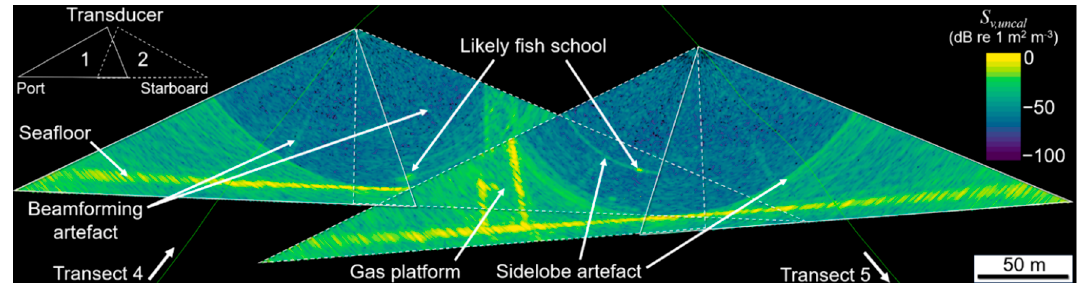
Figure 4. 3D oblique view of the transducer swaths from adjacent transects at site A, showing the degree of swath overlap and examples of beamforming and sidelobe artefacts, the gas platform, fish schools and the seafloor.